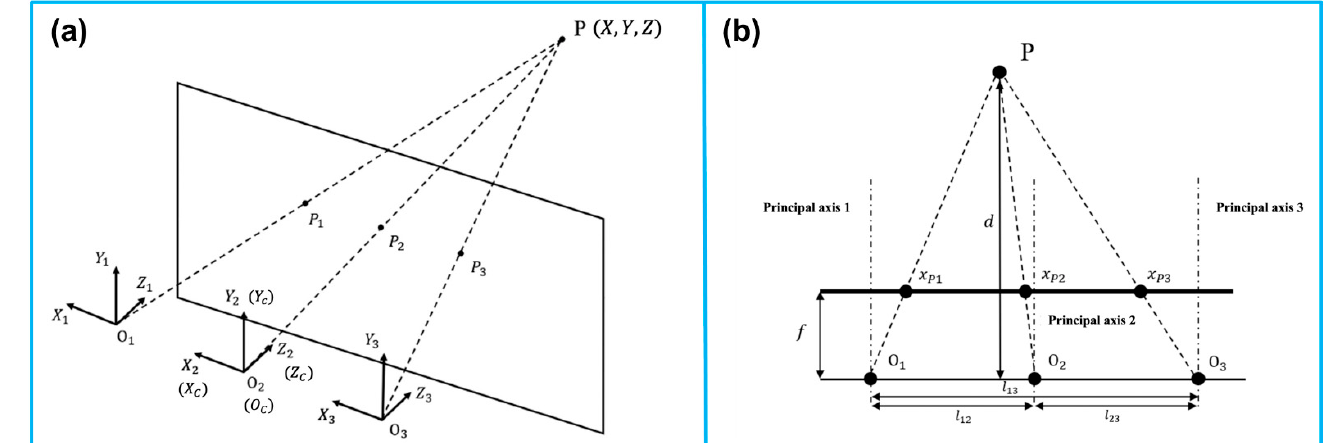
Figure 2. Principle of the camera-based optical tracking technique. ( a ) The three coordinates represent the three lenses integrated in the camera bar. The camera bar is looking at point P ( x , y , z ), where P 1 , P 2 , and P 3 are the intersections on the image plane. ( b ) The top view demonstrates the similar triangles used to calculate the position information. The depth d of point P can be determined via triangulation. Reprinted from [20] with permission.